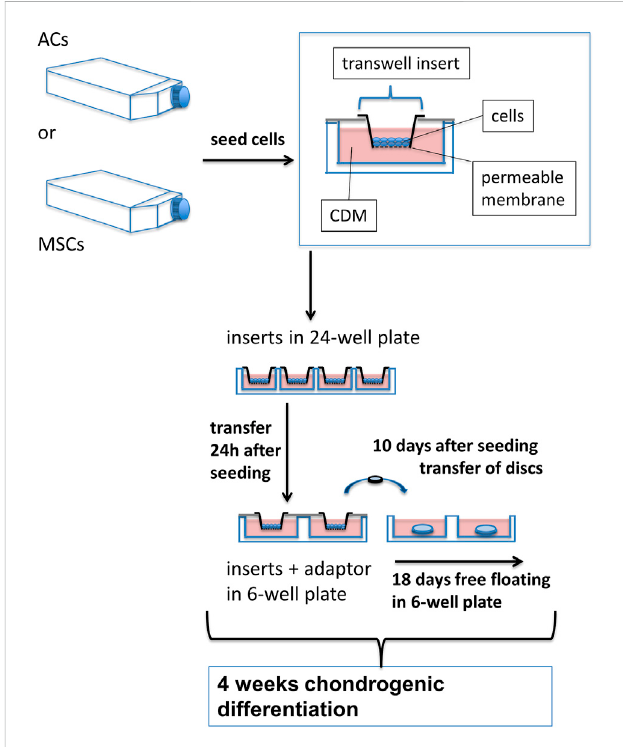
FIGURE 1 Experimental setup for growing AC and MSC discs. ACs and MSCs from three different donors for each cell type were expanded and then seeded in CDM in transwell inserts, hanging in 24-well plates. 24 h after seeding in CDM, inserts were transferred to 6-well plates, using custom made adaptors. After 10 days of chondrogenic differentiation, AC and MSC discs were released from transwell inserts and kept free- fl oating in CDM for 18 further days. N = 3 for each experimental